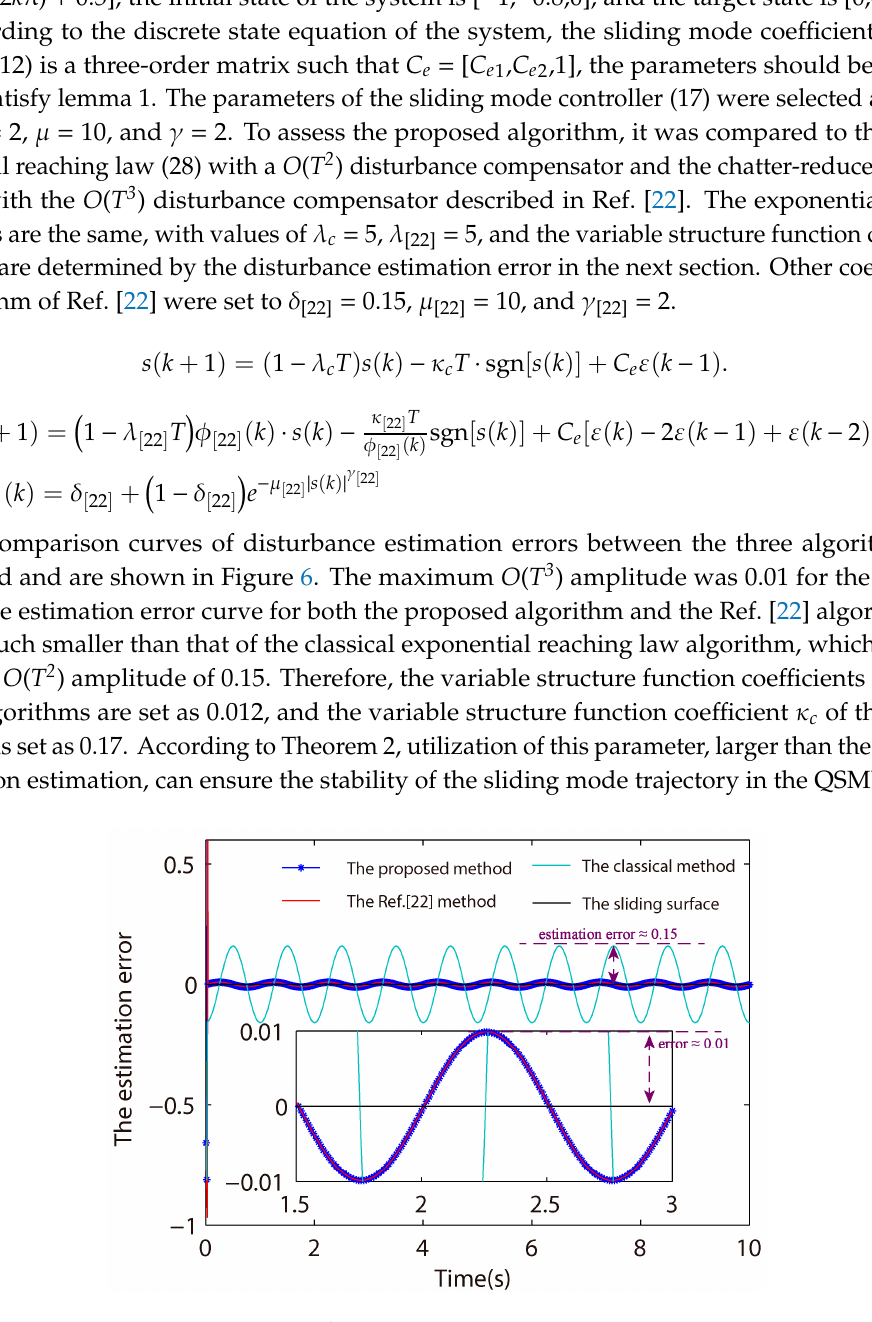
Figure 7. Sliding mode trajectory contrast curves.